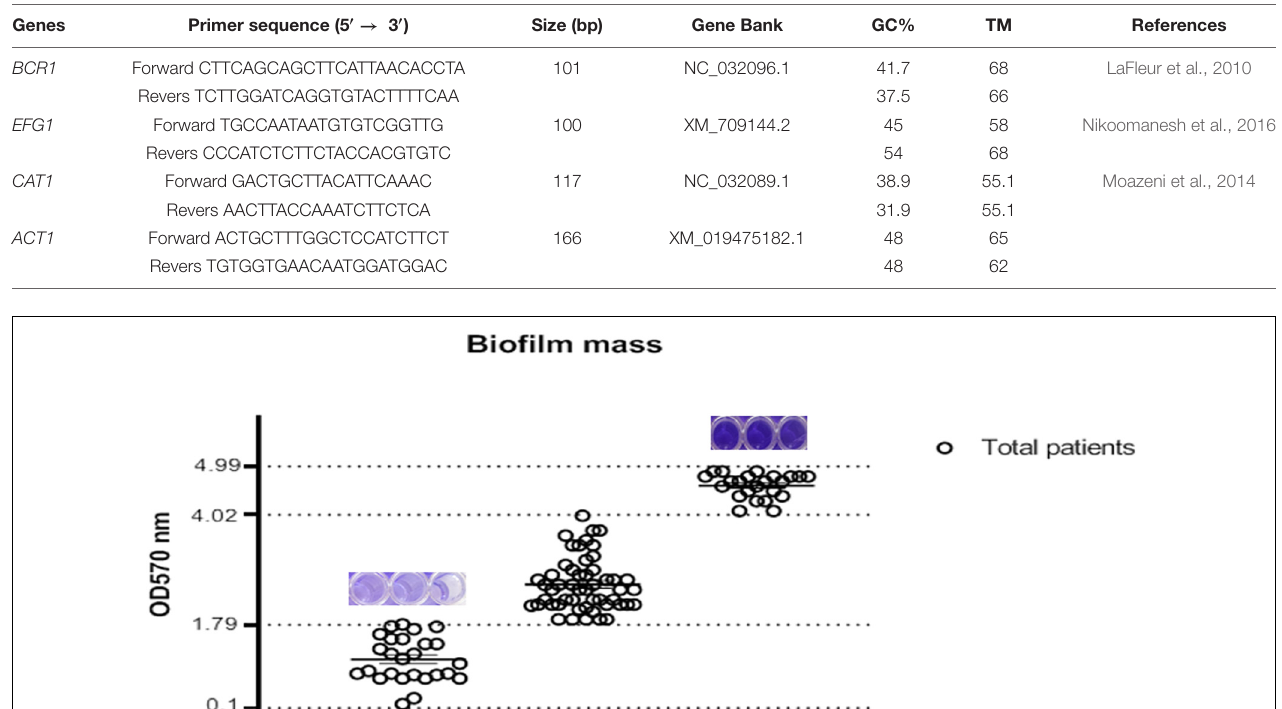
TABLE 2 | qPCR primers.